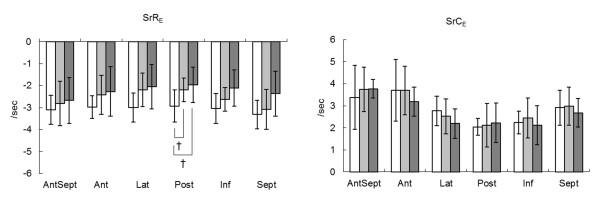
Segmental values of radial and circumferential strain rates during early diastole at apical and Ct levels in affected (black bars), carrier (gray bars), and normal (white bars) dogs. Data were shown as mean ± SD.†: Significant difference compared with normal dogs by multiple comparisons (P < 0.05).SrRE = Peak radial strain rate during early diastole, SrCE = Peak circumferential strain rate during early diastole, AntSept = anteroseptum, Ant = anterior, Lat = lateral, Post = posterior, Inf = inferior, Sept = septum